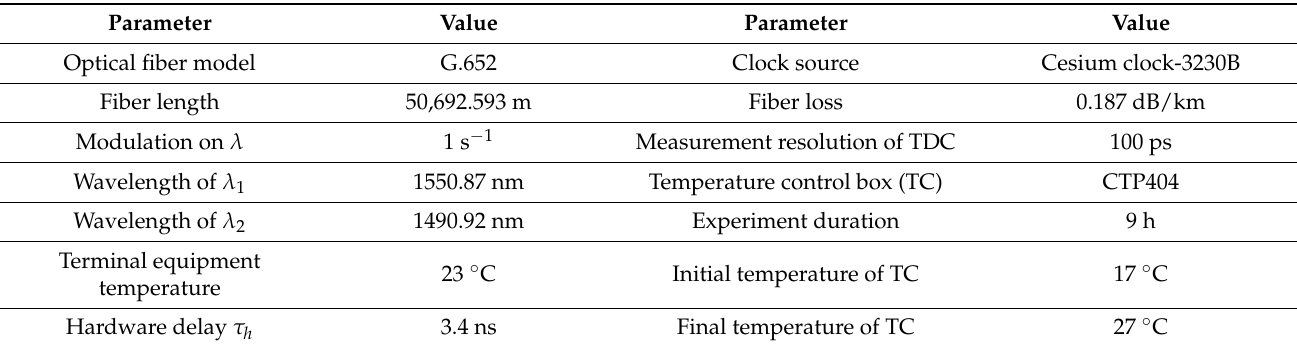
Table 1. Experimental setup parameters.